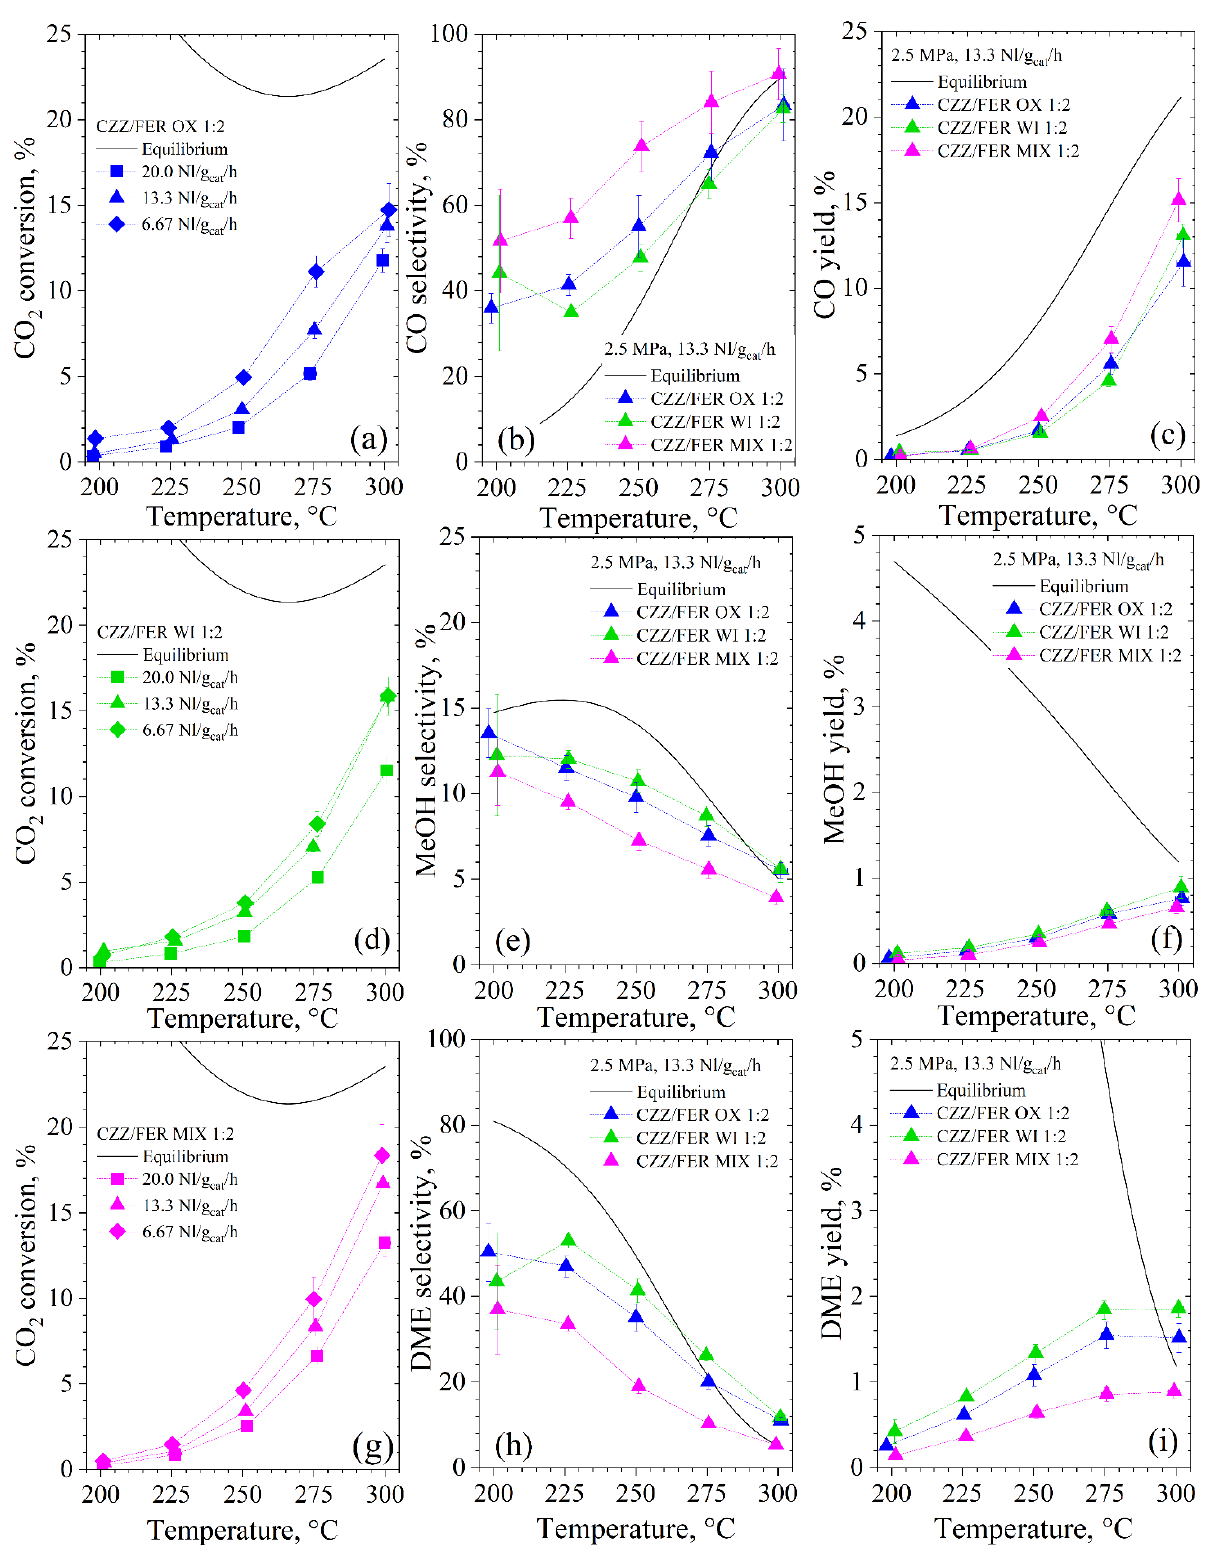
Figure 5. CO 2 conversion of ( a ) CZZ/FER OX 1:2, ( d ) CZZ/FER WI 1:2 and ( g ) CZZ-FER MIX 1:2. ( b ) CO, ( e ) CH 3 OH and ( h ) DME selectivity at 13.3 N L∙g cat −1 ∙h −1 and ( c ) CO, ( f ) CH 3 OH and ( i ) DME yield at 13.3 N L∙g cat −1 ∙h −1 . Reaction conditions: 2.5 MPa, inlet molar ratio H 2 /CO 2 /N 2 , 3/1/1. Undergoing a fast dehydration rate, MeOH yield appears extremely low. However, it slightly increases as the temperature rises when the process approaches thermodynamic